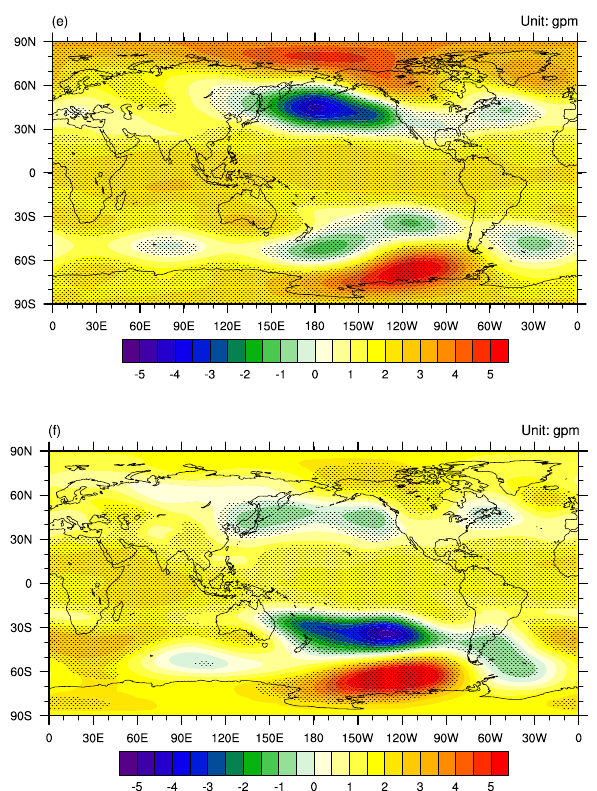
Figure 10. Regression patterns of sea level pressure (SLP) anomalies ( a – c , unit: hPa) and 500 hPa geopotential height anomalies ( d – f , unit: gpm) with respect to sea surface temperature (SST) anomalies over the Bering Sea ( a , d ), NW Pacific ( b , e ) and WT Pacific ( c , f ) from the control (CTRL) run. Stippling indicates regression significant at the p = 0.05 level based on a r -test.